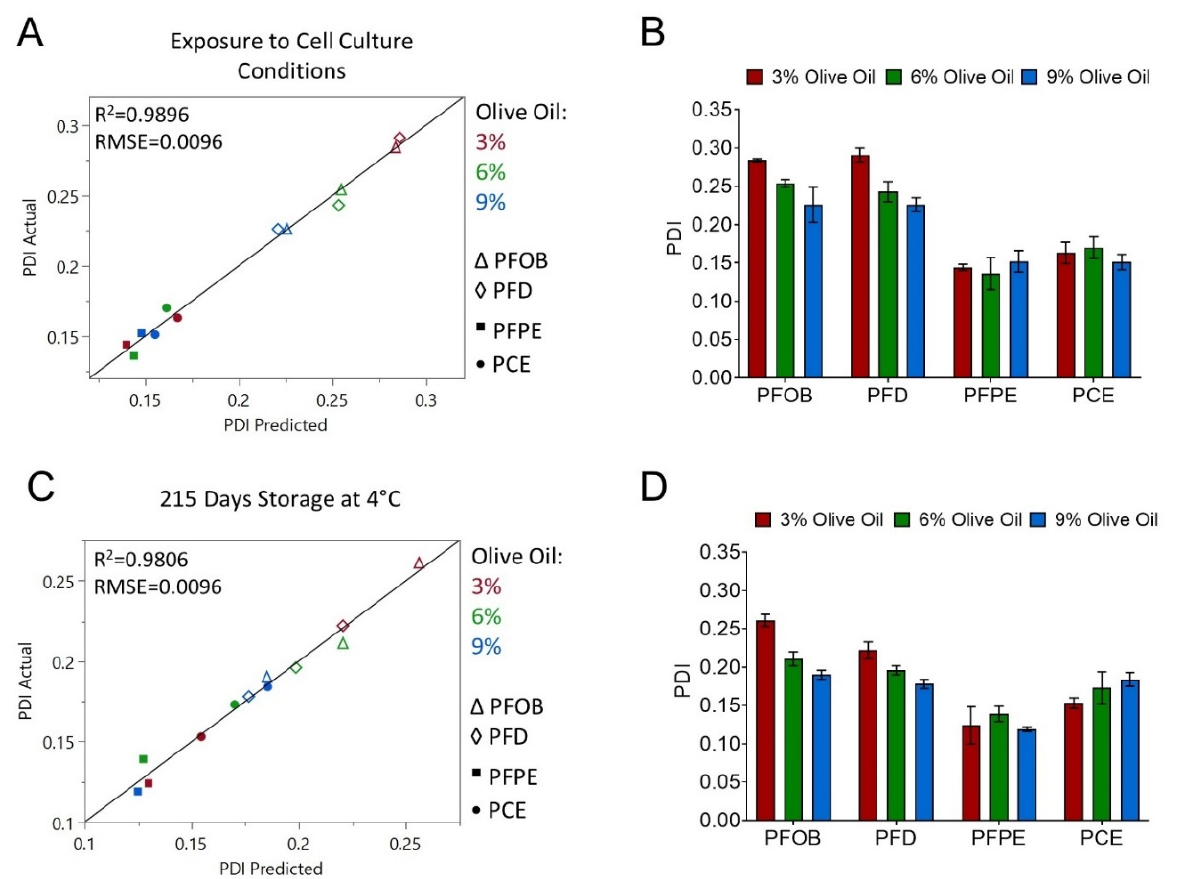
Figure 3. MLR models were developed to predict ( A , B ) nanoemulsion PDI after exposure to cell culture conditions and ( C , D ) after 215 days storage at 4 °C.